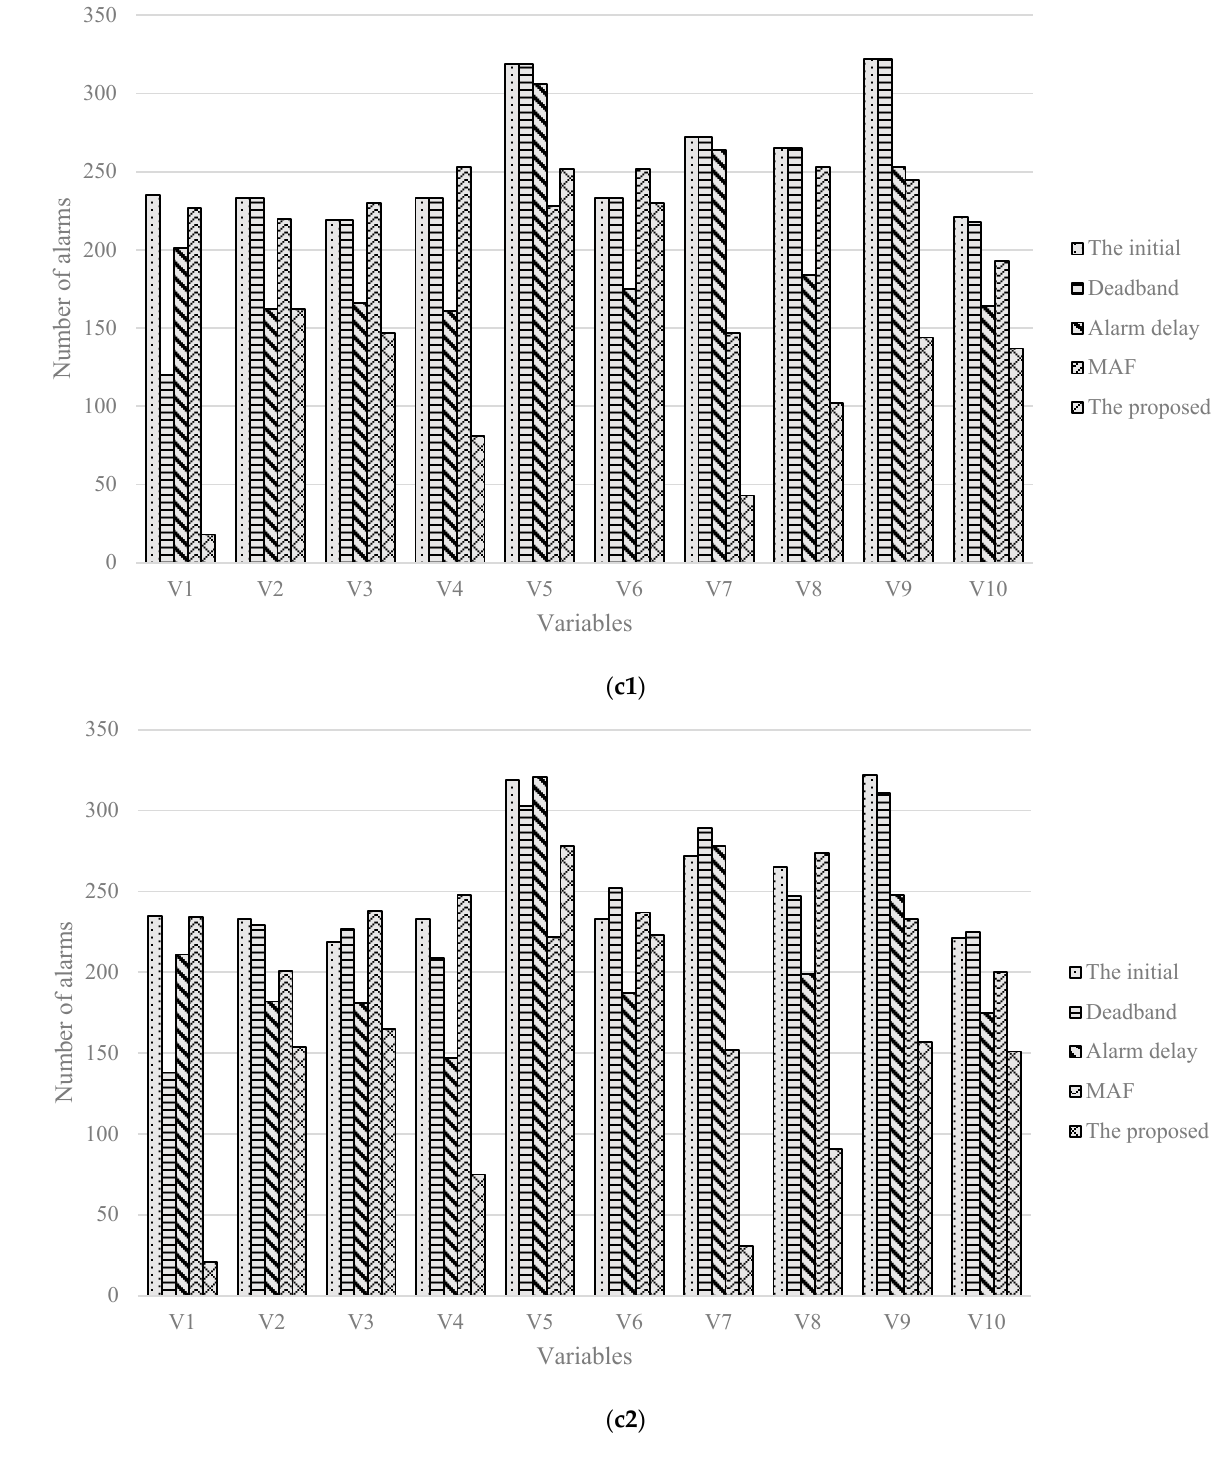
Figure 13. Histograms of number of alarms in five cases with two cases ( c1 , c2 ).